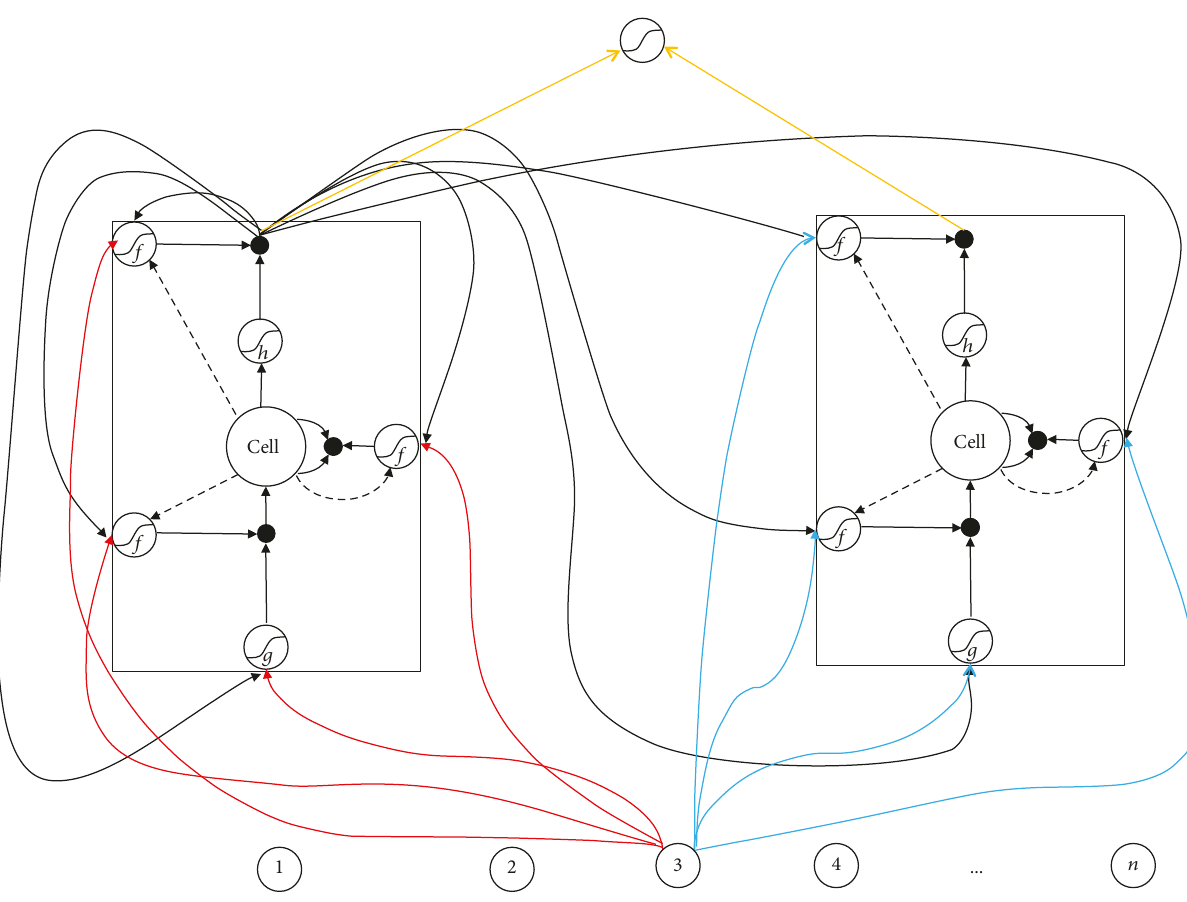
Figure 9: Schematic diagram of two-layer network LSTM structure.